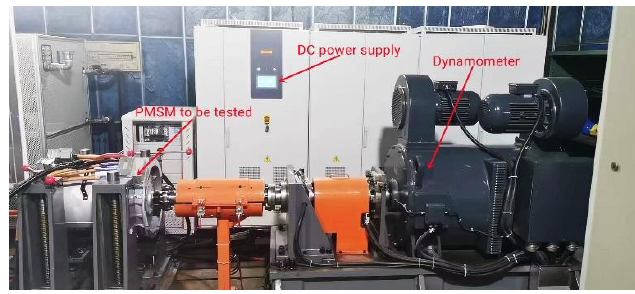
Figure 6. Physical picture of test bench.